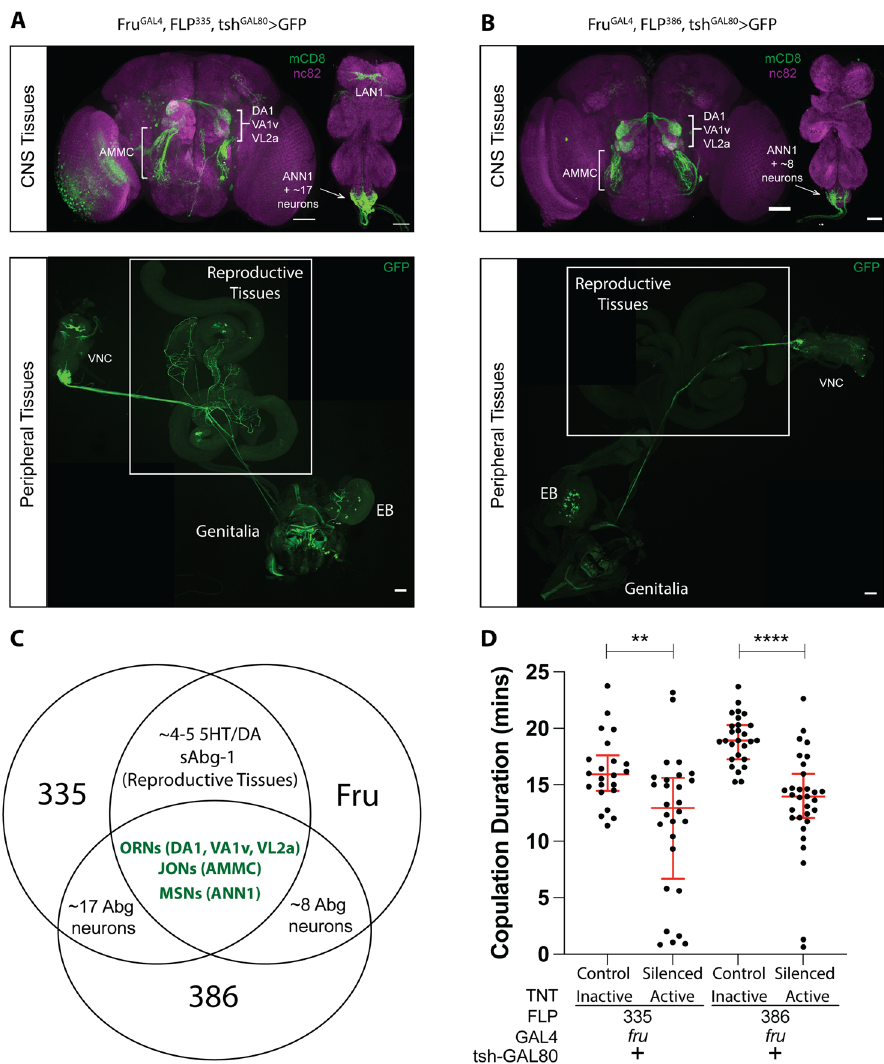
Figure 1. Different groups of fru neurons regulate copulation duration. ( A , B ) Comparison of fru neuronal expression restricted by two different FLP lines. Expression profile of Fru GAL4 , FLP 335 , tsh GAL80 > mCD8::GFP ( A ) is compared to that of Fru GAL4 , FLP 386 , tsh GAL80 > mCD8::GFP ( B ). CNS tissues were stained with anti-mCD8 (green) and nc82 (magenta) and peripheral tissues were stained with anti-GFP (green) only. Expression in the reproductive tissues was notably eliminated via FLP 386 . Scale Bar = 50 µm. (Video 1) Confocal stack of the male genitalia of Fru GAL4 , FLP 386 , tsh GAL80 > mCD8::GFP showing individual neurons at the clasper. Tissue was stained with anti-GFP. ( C ) Venn diagrams highlighting the common fru neurons targeted by both FLP lines as shown in ( A ) and ( B ). Names of the arbors are in brackets followed by the names of the neuronal cluster where they are originated. Three common fru neurons were consistently labeled by both FLP lines: (1) the sexually dimorphic projections in the glomeruli from fru ORNs (DA1, VA1v, VL2a), (2) projections in the antennal mechanosensory motor complex (AMMC) from fru JONs, (3) projections in the abdominal ganglion (ANN1) from fru MSNs in the genitalia. See also Table 1 in text. ( D ) Effect of silencing FLP 335 and FLP 386 restricted labeling of fru -GAL4. A shortened copulation duration was observed in both genetic combinations, therefore, the common neuronal clusters targeted by both FLP lines (ORNs, JONs, MSNs) were responsible for the copulation phenotype. Black dots are individual values. Red lines indicate the median with interquartile range (n = 22–31). **p < 0.0034, ****p < 0.0001 by Mann Whitney